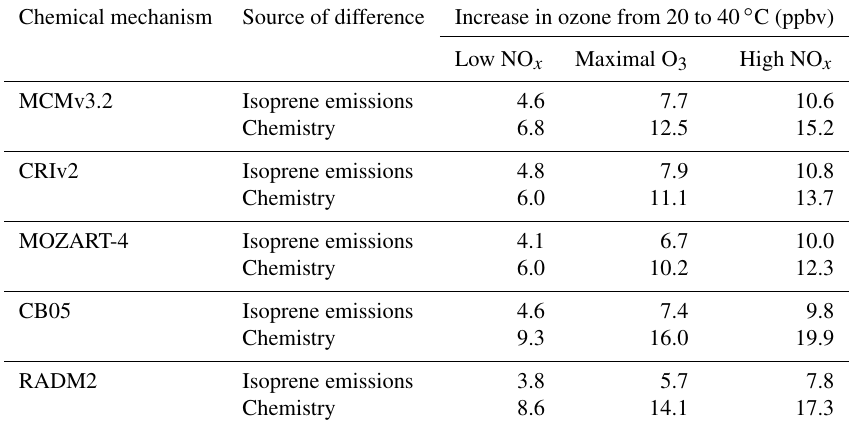
Table 2. Increase in mean ozone mixing ratio (ppbv) due to chemistry (i.e. faster reaction rates) and temperature-dependent isoprene emis- sions from 20 to 40 ◦ C in the NO x regimes of Fig.